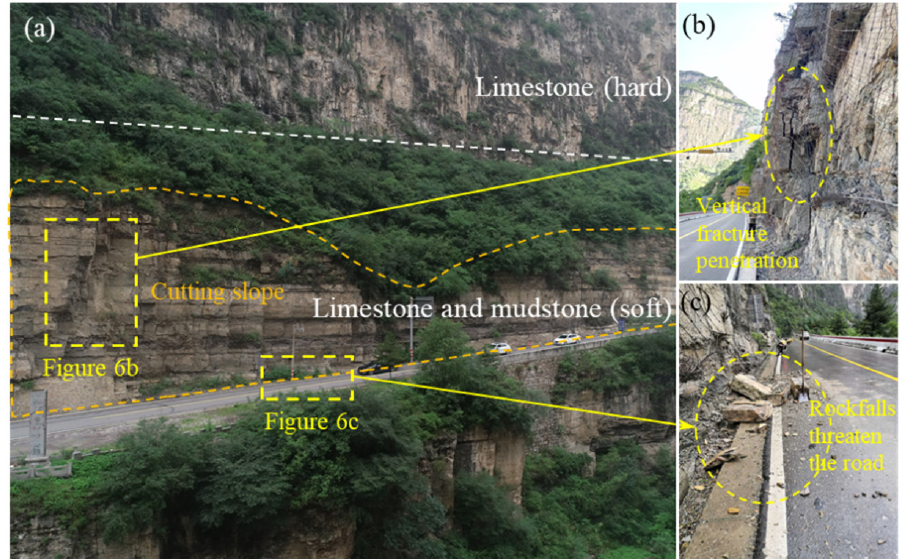
Figure 6. Potential rockfall point at the entrance of the Hongdou Gorge scenic spot. ( a ) Overall view of the potential rockfall point. ( b , c ) Photos of small rockfall events with the falling and tension failure model near the road in the scenic spot.